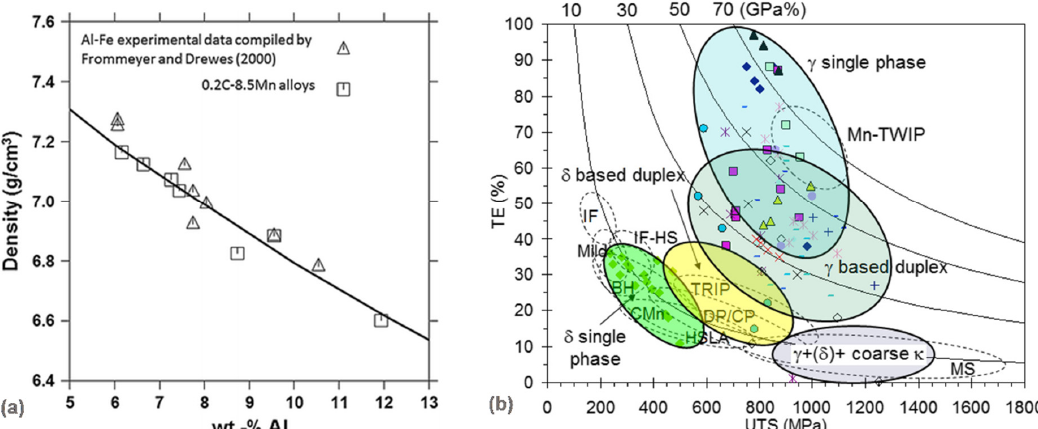
Figure 9. Reducing density of steels for automotive applications: ( a ) density as a function of aluminum content for binary Fe ‐ Al18 and for quaternary 0.2C − 8.5Mn (wt.%) alloys, wherein the continuous line corresponds to the density calculation for the quaternary system using Thermo ‐ Calc [39]; ( b ) elongation (TE) as a function of ultimate tensile strength (UTS) in Fe–Mn–Al–C alloys (solution ‐ treated and water ‐ quenched strips) [40].